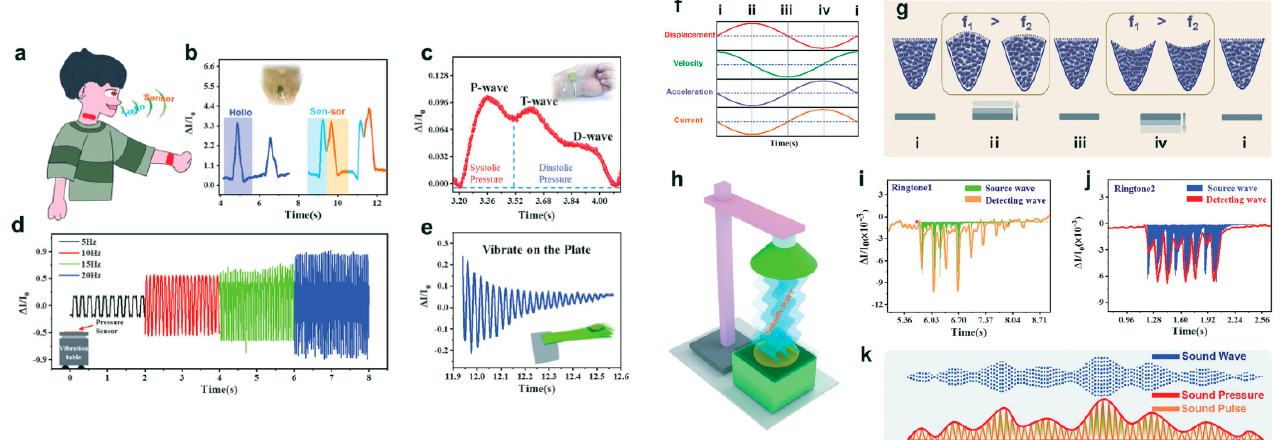
Figure 12. Schematic diagram of a pressure sensor as a wearable device for physiological signal detection ( a ). Corresponding signals for saying “hello” and “sensor” ( b ). Corresponding signal for the pulse on the medial wrist ( c ). Corresponding signal of the pressure sensor vibrating at different frequencies on the shaker ( d ). Corresponding signals of the pressure sensor vibrating on plate ( e ). Corresponding relationship between current values, displacement, velocity and acceleration in the vibration mode ( f ). Schematic diagram of the density of MXenes at different vibration stages ( g ). Diagram of a sound wave hitting a pressure transducer ( h ). Schematic diagram of the acoustic pressure on the sensor surface associated with sound waves and sound pulses (i). Corresponding detection signals and source waves for the two ringtones ( j − k). Reprinted with permission from Ref. [140]. Copyright 2020, Wiley-VCH.